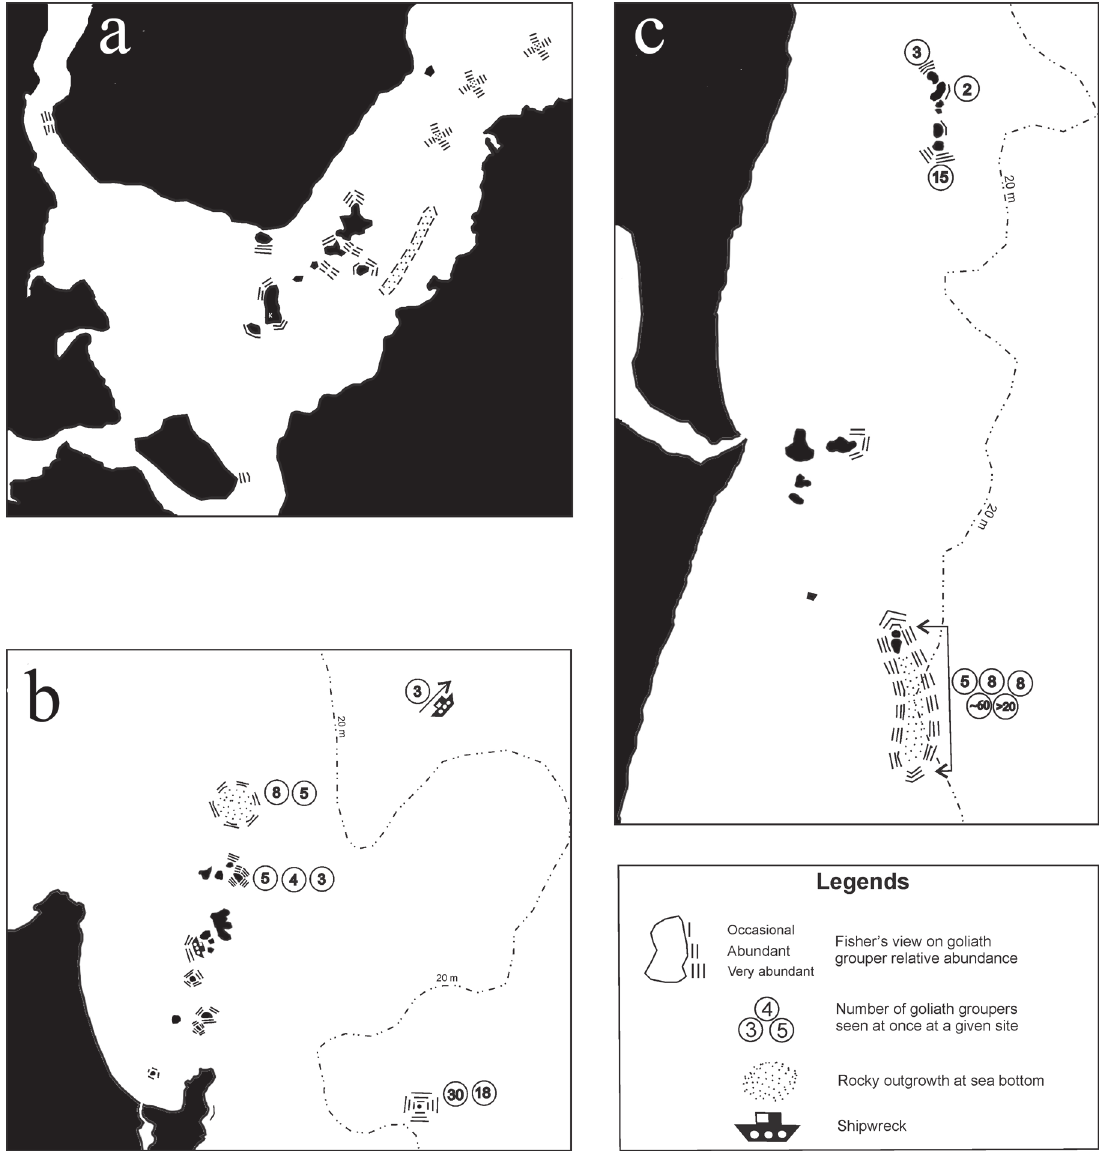
Fig. 2. Fishermen resource mapping of goliath grouper relative abundances and aggregations at Babitonga Bay (a) and surrounding areas (b and